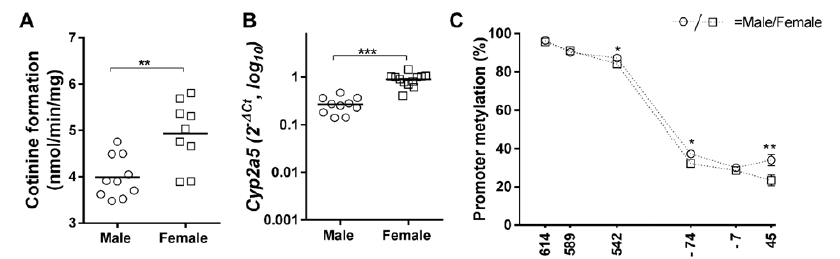
Figure 2. Comparisons of Cyp2a5 mRNA expression and promoter methylation status between control male and female in the liver. ( A , B ) figures represent comparisons of cotinine levels and Cyp2a5 mRNA expression between male and female in control liver and lung. ( C ) figure represents sex-dependent comparisons of Cyp2a5 promoter regions between male and female in control liver and lung. Data of the 6 targeted CpG-sites are presented per sex and exposure as individual values with median as a horizontal line. Circle ( ○ ) symbol(s) = male, square (□) symbol(s) = female. If not stated otherwise, the comparison of shown groups was not significant. * p ≤ 0.05, ** p ≤ 0.01, *** p ≤ 0.001 (Mann–Whitney U -test). Open symbol(s) = control